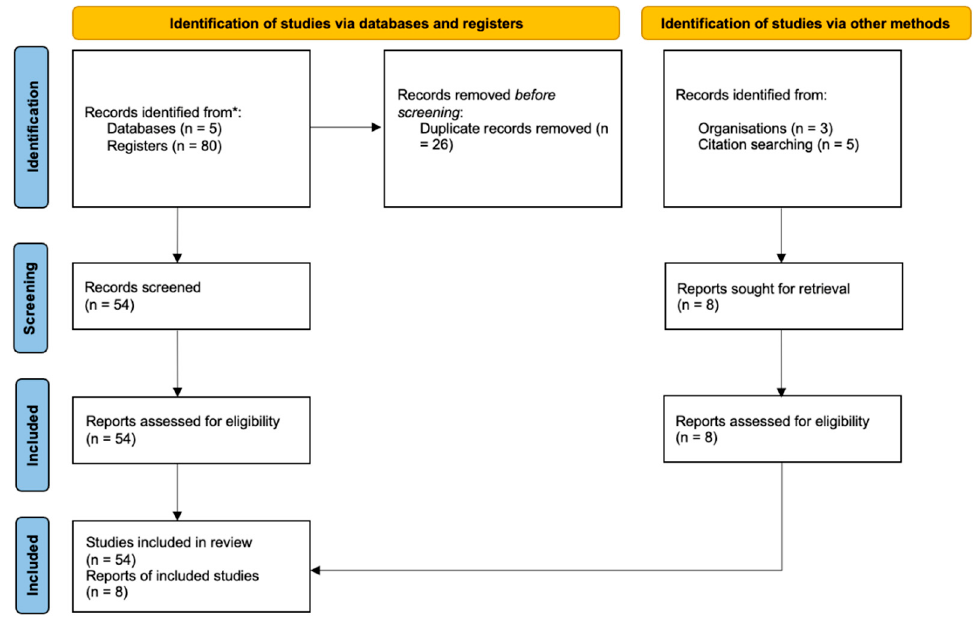
Figure 2. Preferred reporting items for systematic reviews and meta-analysis (PRISMA) stages. Table 2. List of used databases.